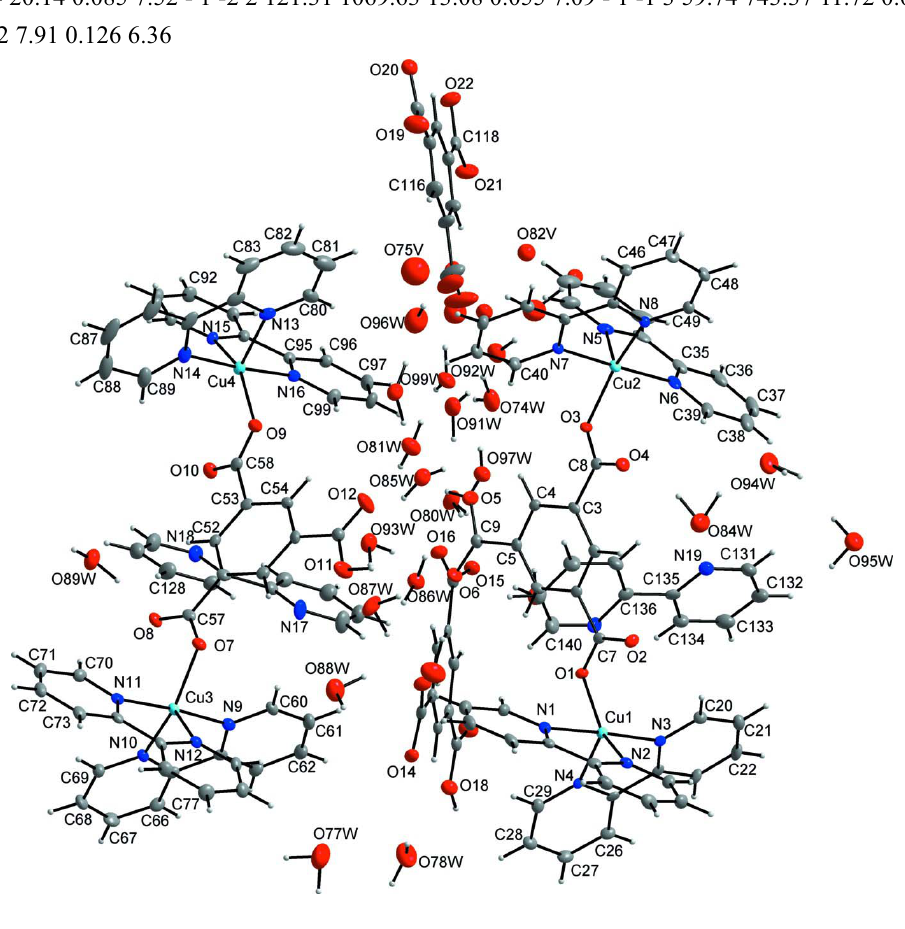
refined, with the O—H distances restrained to 0.85 (2) Å and with U Table 1. The maximum and minimum residual electron density peaks were located with distances 1.10 and 0.80 Å from the O24 atom. A profile of a few (namely 7) low angle reflections has been strongly influenced by shielding by the beam-stopper, therefore these reflextions were excluded from the refinement.